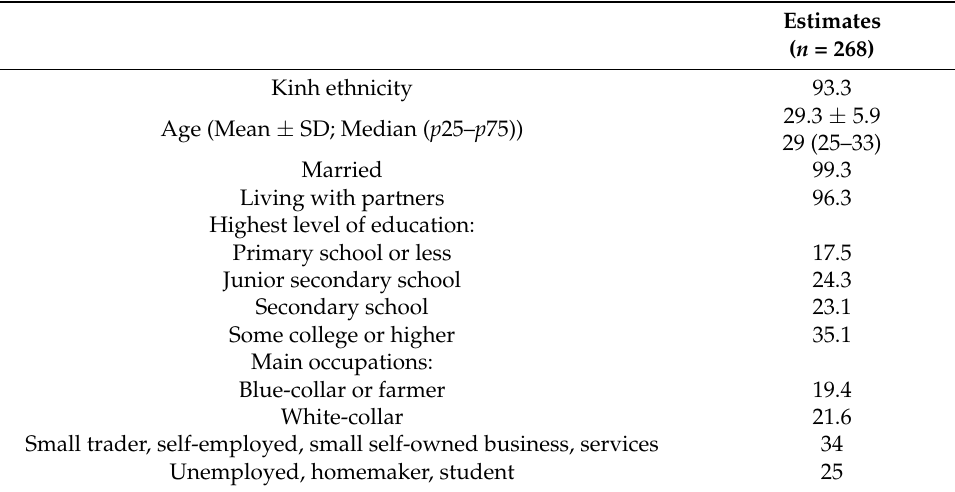
Table 1. Socioeconomic characteristics of pregnant women 1 .